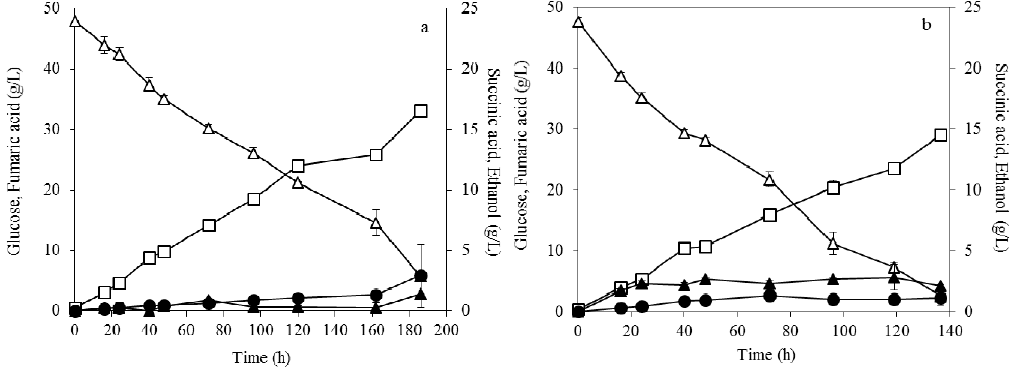
Figure 8. Fumaric acid ( □ ), ethanol ( ▲ ) and succinic acid ( ● ) production during submerged fermentation of R. arrhizus NRRL 2582 at ~50 g/L of initial glucose ( △ ) concentration using ( a ) 200 mg/L and ( b ) 400 mg/L FAN of soybean cake hydrolysate as nitrogen source in the preculture medium. The initial ammonium sulphate concentration was 0.2 g/L.